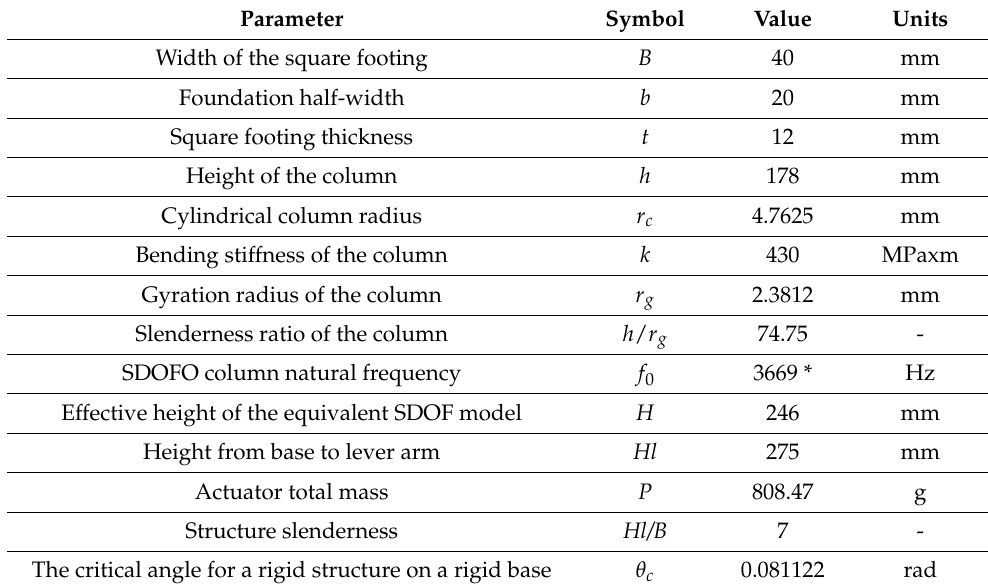
Table 2. Electromechanical oscillator parameters and their measures. Parameter Symbol Value Units Width of the square footing B 40 mm Foundation half-width b 20 mm Square footing thickness t 12 mm Height of the column h 178 mm Cylindrical column radius r c 4.7625 mm Bending stiffness of the column k 430 MPaxm Gyration radius of the column r g 2.3812 Slenderness ratio of the column h / r g 74.75 - SDOFO column natural frequency f 0 3669 * Hz Effective height of the equivalent SDOF model H 246 mm Height from base to lever arm Hl 275 mm Actuator total mass P 808.47 g Structure slenderness Hl/B 7